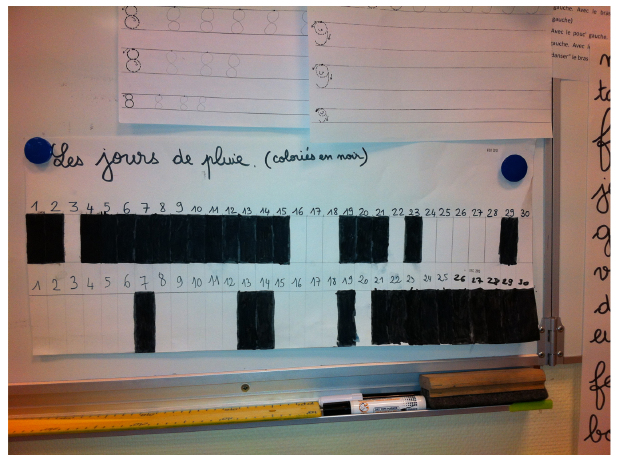
Figure 6. Daily time series of rainfall occurrence recorded by a class of 5–6-year-old children in Sceaux, France in October– November